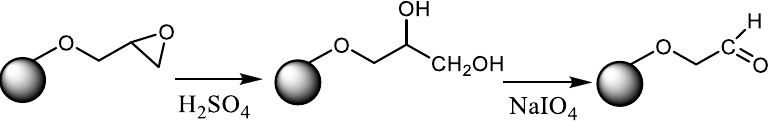
Figure 1. The functionalization of epoxy-activated supports based on methacrylate polymers with glyoxyl groups.